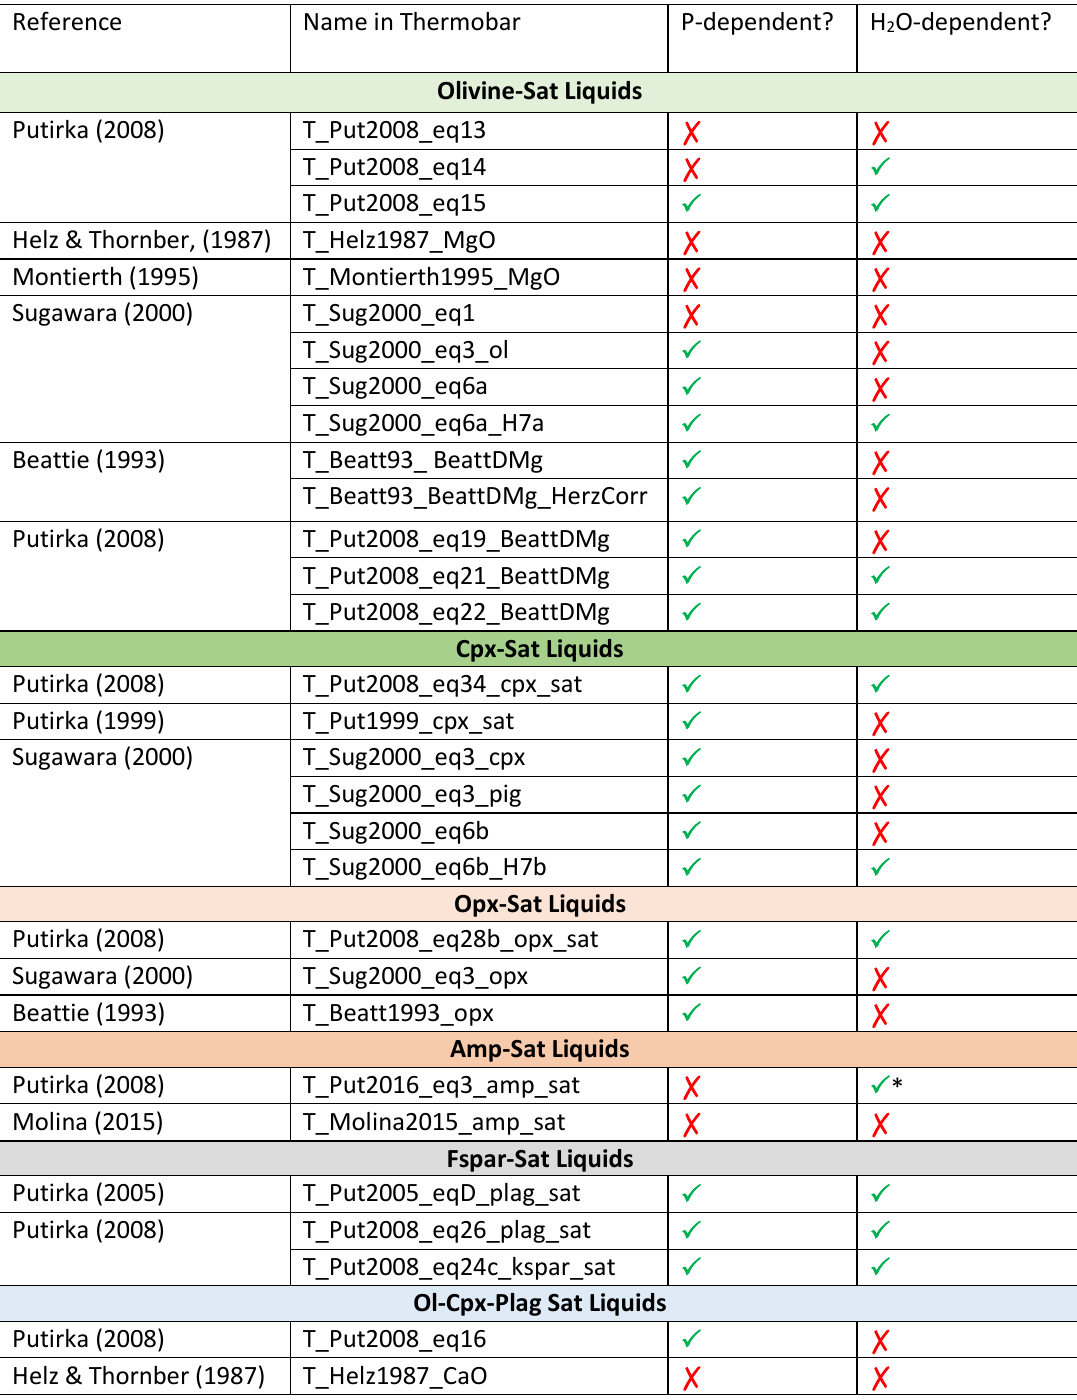
Table A1: Summary of equations for liquid-only thermometry. *Note, Putirka 2016 equation 3 does not contain a H H O-sensitive because liquid cation fractions are calculated on a hydrous basis. Equations from: Putirka 2008, Sugawara 2000, 2 Montierth et al. 1995, Helz and Thornber 1987, Beattie 1993, Herzberg and O’hara 2002, Putirka 1999, Molina et al. 2015, Putirka